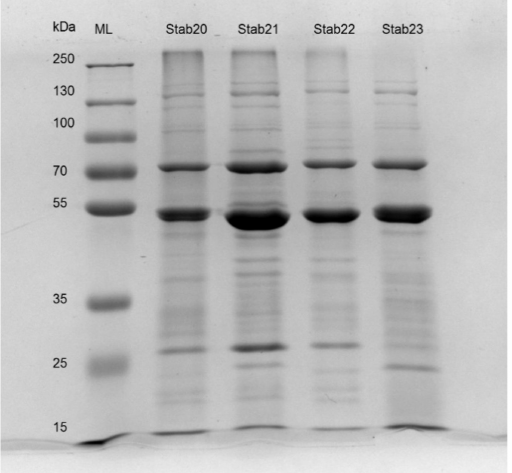
Figure 5. SDS-PAGE (10% acrylamide) of Stab20, Stab21, Stab22, and Stab23 showing major similarity and distinction among the phages’ structural proteins. ML—molecular ladder (broad range molecular mass marker,